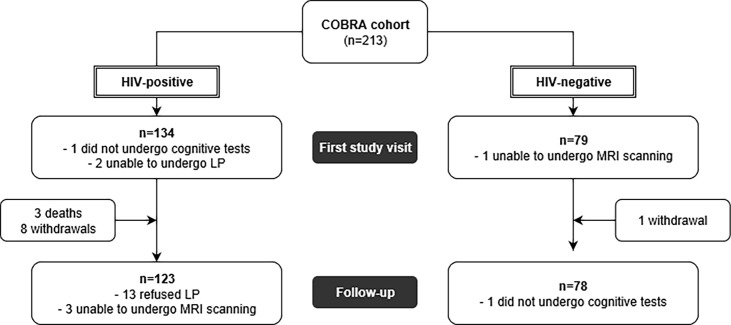
Flowchart of COBRA study participants.